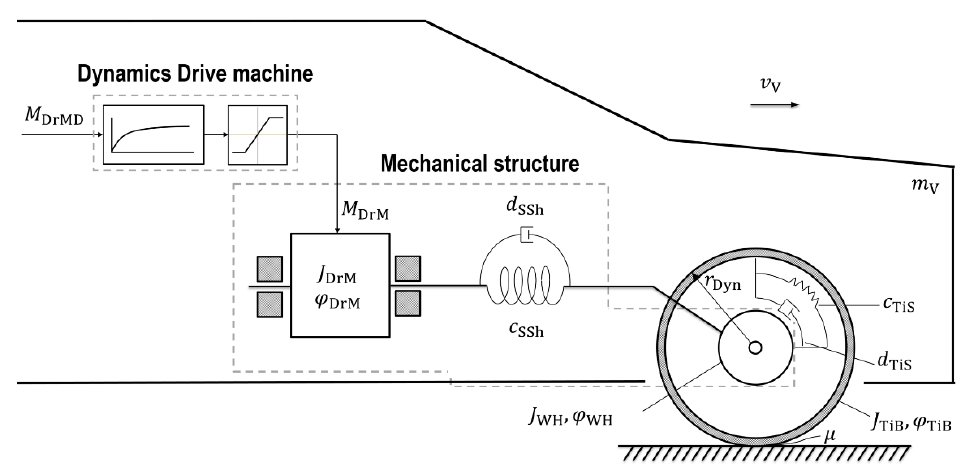
Figure 6. Simplified system of an electrified vehicle drive system.